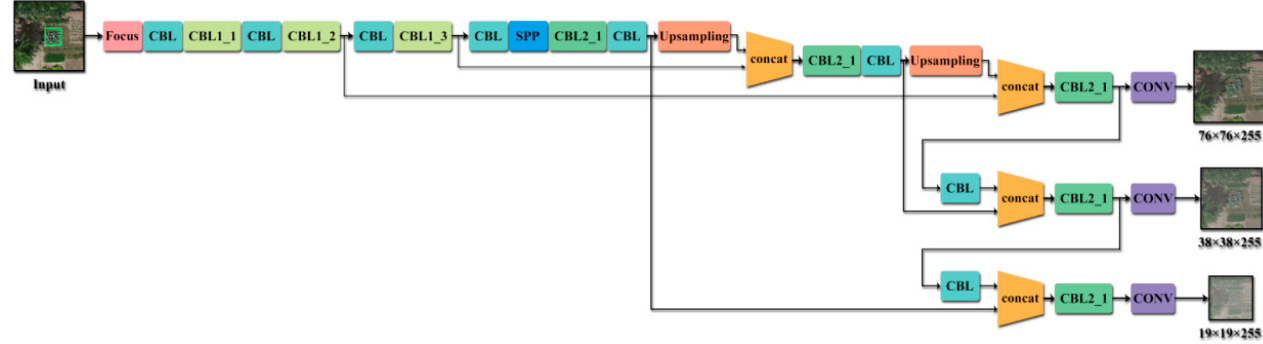
Figure 3. Network structure of YOLOv5.